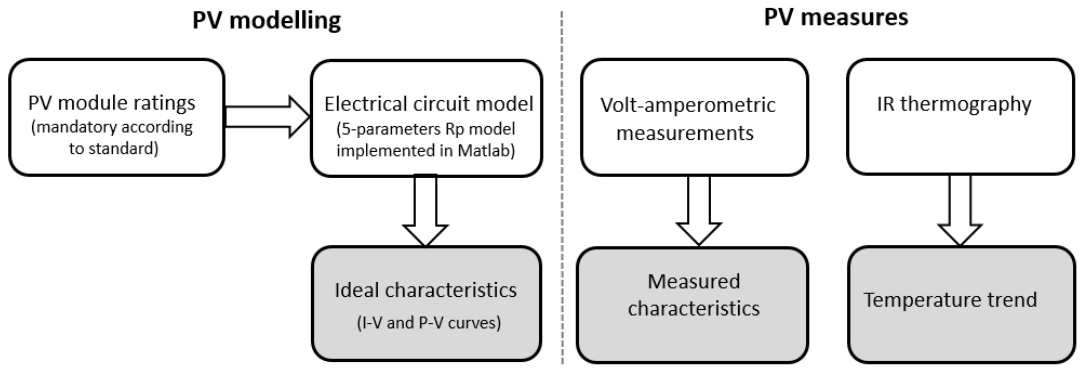
Figure 1. Employed Figure 1. Employed methodology.